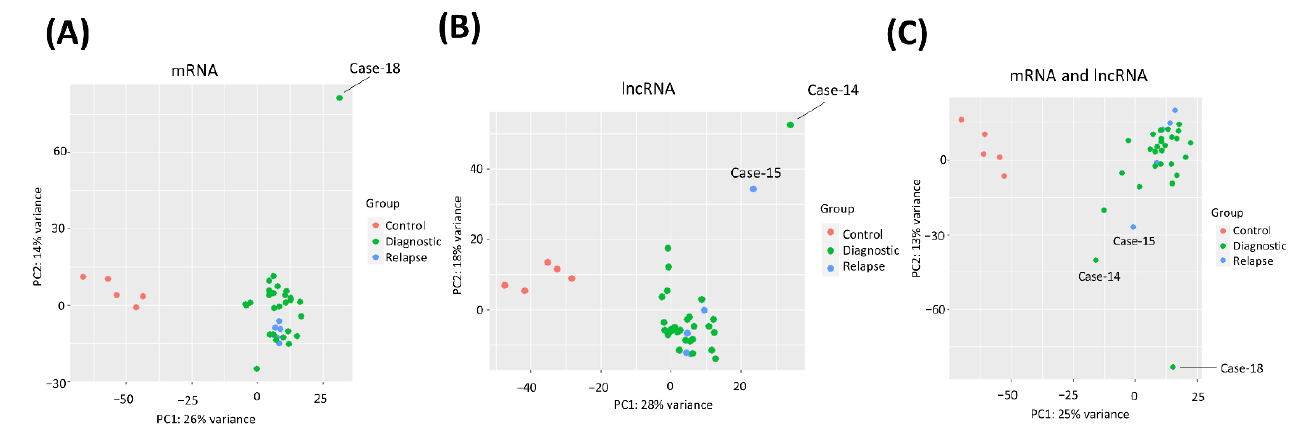
Figure 3. PCA plots of reactive tonsil B-cell subsets and MCL cases. PCA plots of diagnostic, re- lapsed MCL, and control samples generated based on only mRNA ( A ), only lncRNA ( B ), or both mRNA and lncRNA ( C ) transcript expression profiles are shown. Control samples represent reactive tonsil B-cell subset samples used for WTS. The patient codes of the outlier cases are indicated on the plots.